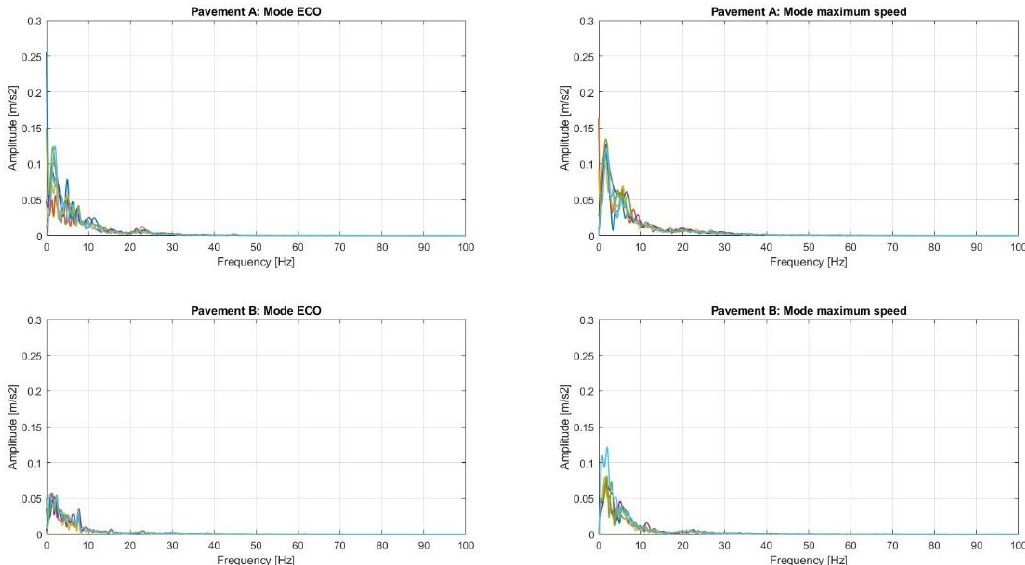
Figure 13. Frequency response analysis of longitudinal acceleration.